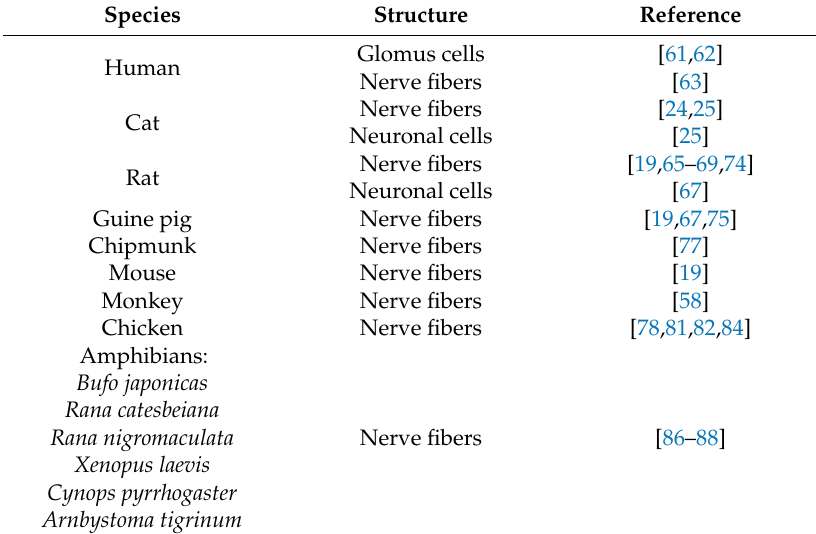
Table 1. The presence of VIP in the carotid body summary of current